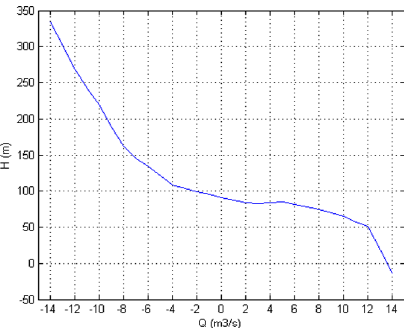
Fig. 2. H – Q pump curve (550rpm).